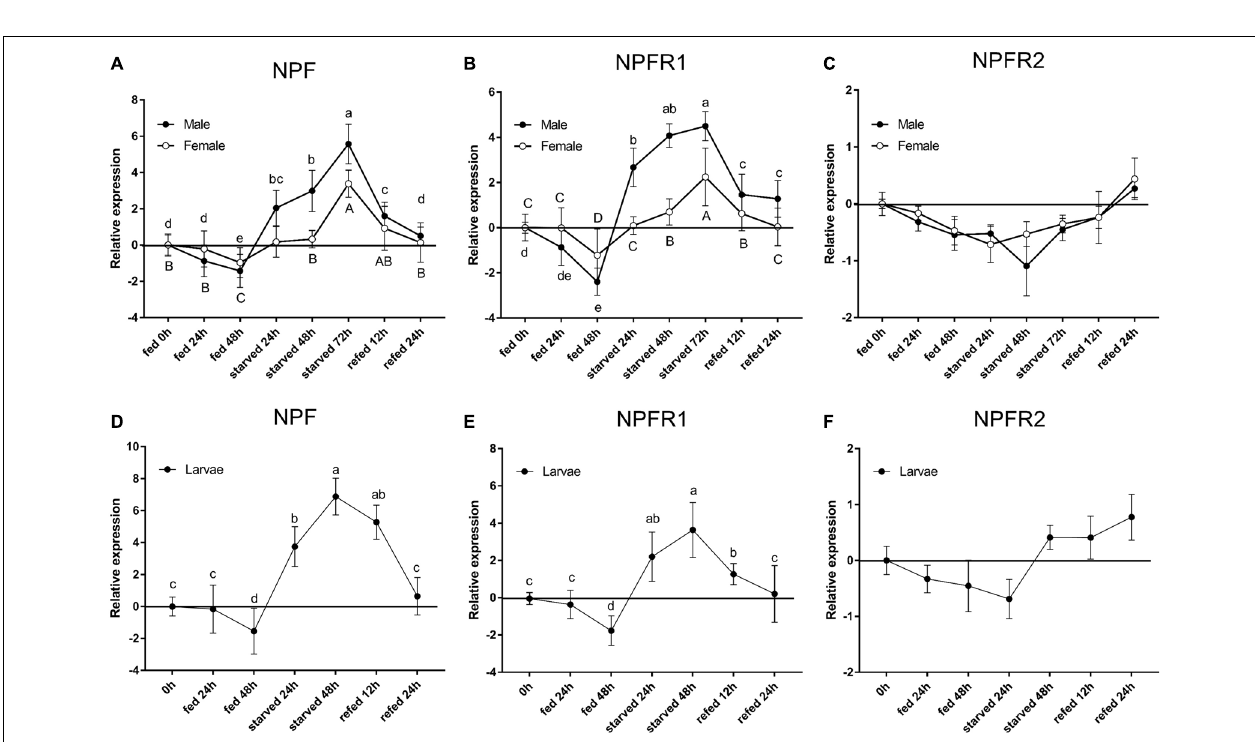
FIGURE 3 | Relative expression levels of emerged adults of NPF (A) , NPFR1 (B) , NPFR2 (C) , and mature larvae of NPF (D) , NPFR1 (E) , and NPFR2 (F) in D. armandi after starvation and subsequent re-feeding treatment. The relative expression levels were normalized with β -actin and CYP4G55 using the expression levels in 0 h for calibration. Different letters indicate significant differences at the 0.05 level (uppercase for males, lowercase for females and uppercase for males and larvae, no letter means no significant difference among all time points). All values are mean ± SE , n =